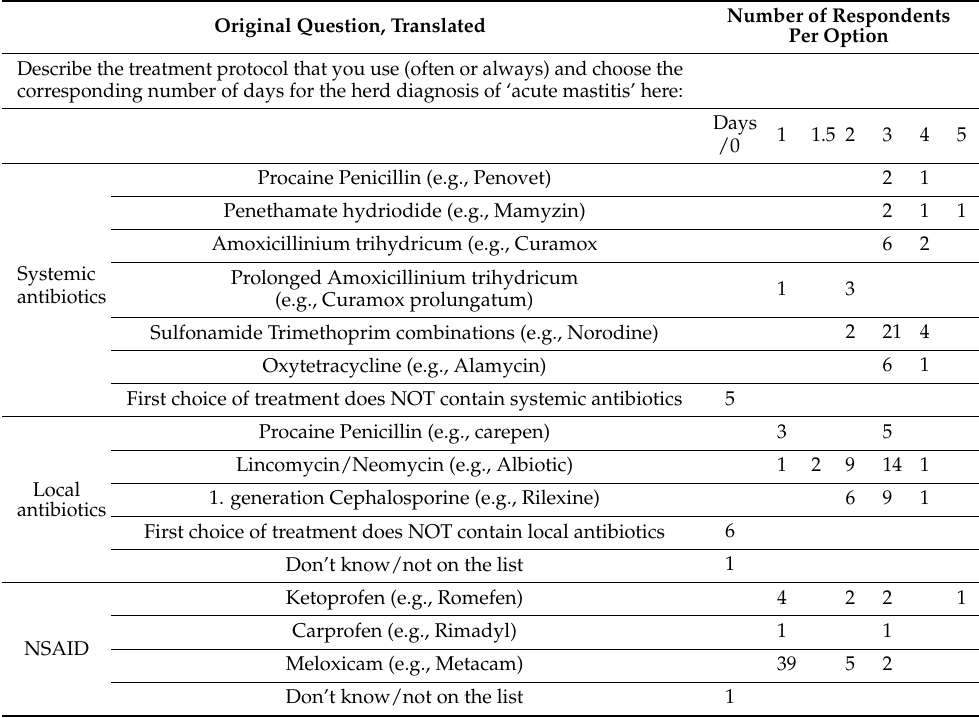
Table A2. Distribution of respondents treatment choice and duration in days for systemic antibiotics, local antibiotics and NSAIDs used often or always by Danish veterinarians ( n = 58) for a herd diagnosis of “acute mastitis”.